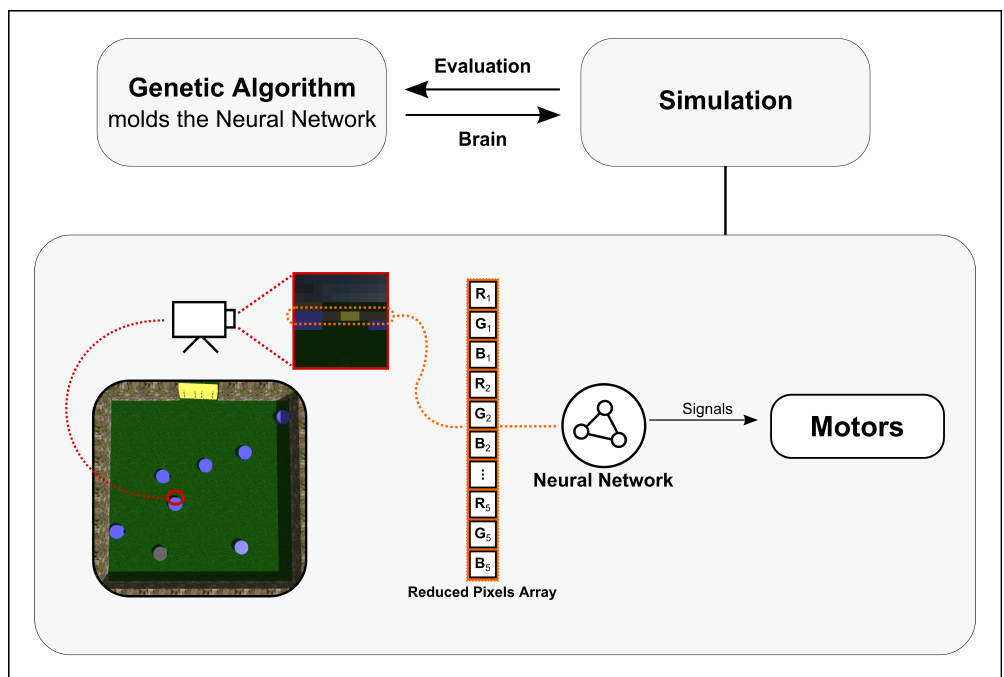
Fig. 1. Overview of the proposed model. Agent is able to move at the environment using its own vision. The proposed artificial visual cortex consists in images captured by a virtual camera. Images of 10 10 pixels in the RGB system are captured and passed to the controller. Since × the agent moves only in two dimensions, it is sufficient to see the central part of the image. Therefore, only the ten pixels from the fifth row are used as vision. These, on the other hand, are reduced to five pixels using the arithmetic mean of RGB components from each two neighbor